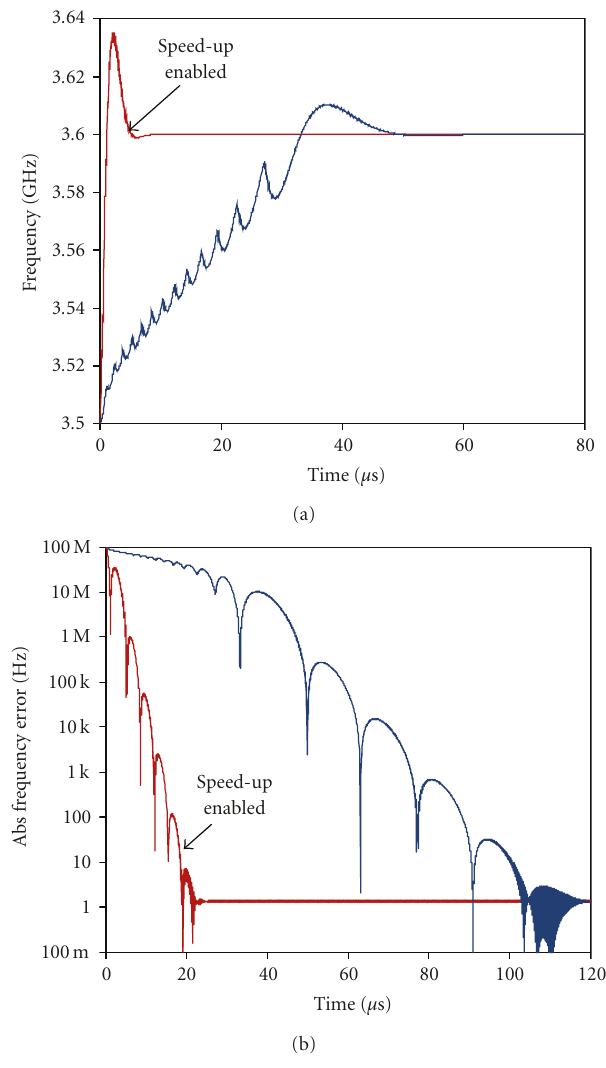
Figure 10: Transient responses of the PLL for two cases: speedup mode enabled/disabled (red/blue line, resp.). Plot (b) shows the absolute frequency error relative to the settling frequency 3.6 GHz.